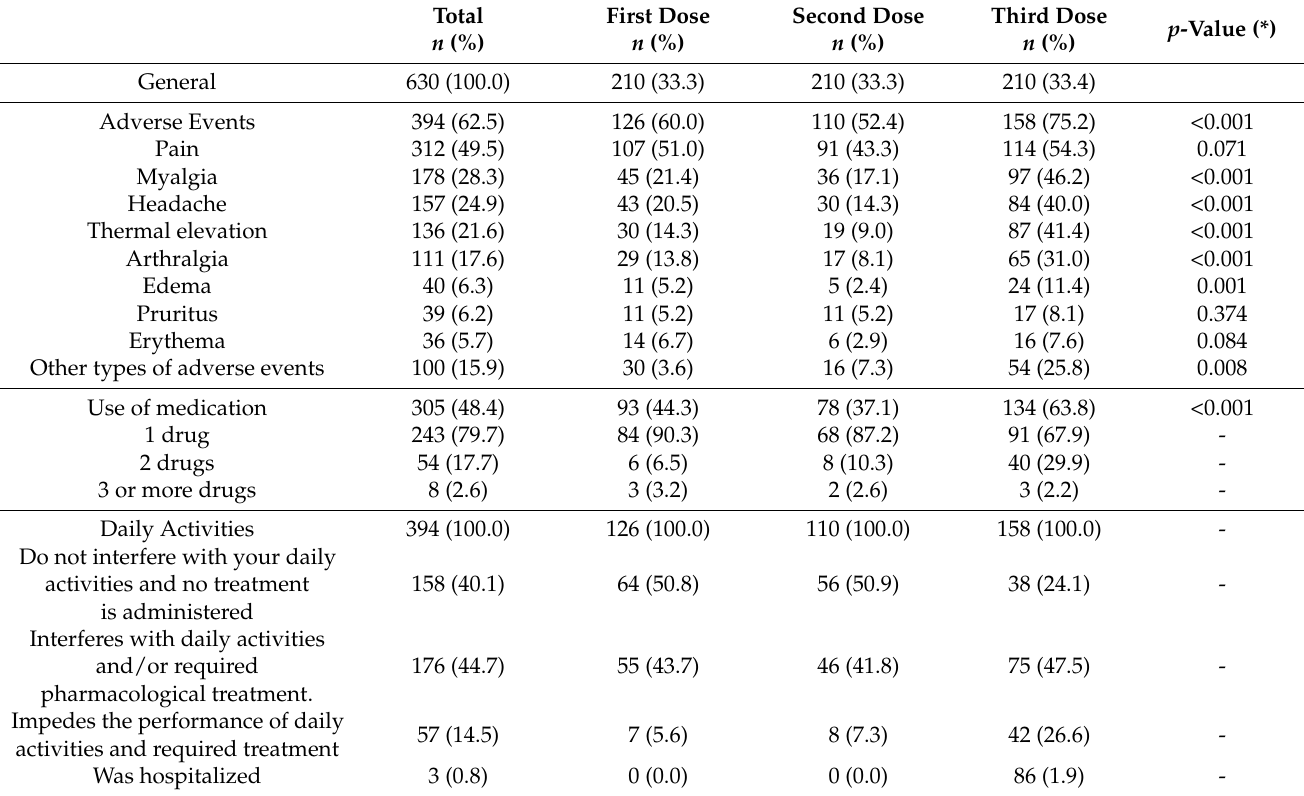
Table 2. Descriptive characteristics of adverse events, medication, and relationship with daily